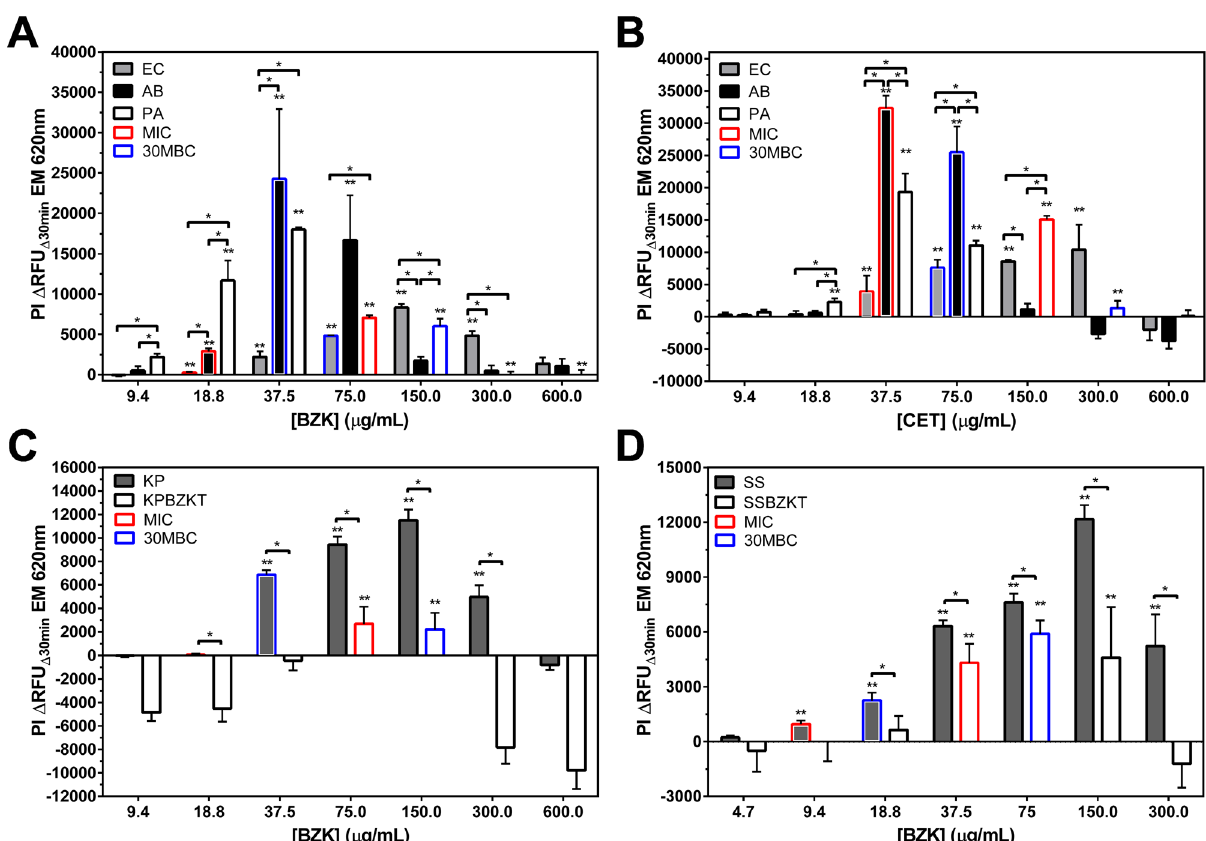
Figure 5. RFDMIA of various Gram-negative species to determine QAC susceptibility. The results of stationary phase RFDMIA of E. coli (EC) ( A , B ), A. baumannii (AB) ( A , B ), P. aeruginosa (PA) ( A , B ) , K. pneumoniae (KP; KPBZKT) ( C ), and S. sonnei (SS; SSBZKT) ( D ) exposed to increasing concentrations of QAC are shown. For each RFDMIA plot shown, a Student’s two-tailed t test was calculated by comparing every QAC concentration PI ΔRFU Δ30min value to the lowest measured QAC concentration PI ΔRFU Δ30min value shown on the plot. This t test was used to identify the lowest QAC concentration with a significant increase in PI ΔRFU Δ30min value, which are indicated as a double asterisk (**) with P < 0.01. The horizontal lines with asterisks indicate interspecies PI ΔRFU Δ30min value comparisons at the same QAC concentrations. Data represents three bacterial bioreplicates (n = 3) measured from averaged technical triplicate